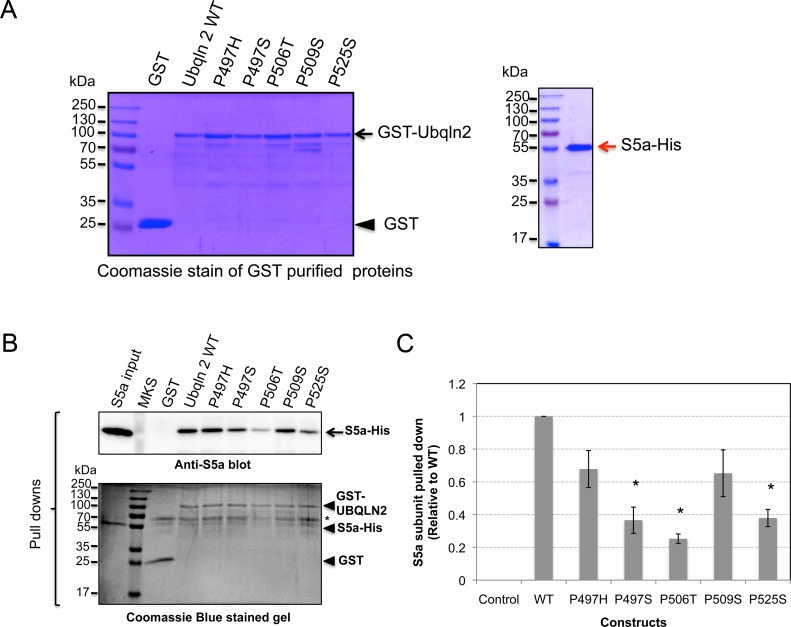
In vitro binding studies showing ubiquilin-2 proteins carrying ALS mutations have reduced binding with the S5a subunit of the proteasome compared with WT ubiquilin-2 protein.(A) Left. SDS-PAGE gel stained with Coomassie Blue stained gels showing the different GST purified proteins (right) and the His-tagged S5a subunit of the proteasome that were used in the binding experiments. (B) Equal amounts of GST or GST-ubiquilin-2 proteins were incubated with a fixed amount of His-S5a for 2 hours. After incubation the beads were washed and the amount of His-S5a that was bound to the beads was analyzed by immunoblotting. Equal amounts of the eluate from the binding experiments were separated by SDS-PAGE together with 1/10 of the input S5a-His protein (Lane 1) and either immunoblotted for S5a, or a parallel gel stained with Coomassie Blue. The positions of the different proteins are marked with arrows. The band marked with an * corresponds to BSA that was added as a blocking agent. (C) Quantification of the GST-pulldown results normalized to WT ubiquilin-2 protein. Errors bars show standard error of the mean. The * signifies a statistical reduction in the binding of S5a by several of the GST-fusion ubiquilin-2 mutants compared to ubiquilin-2 WT (p = <0.05).